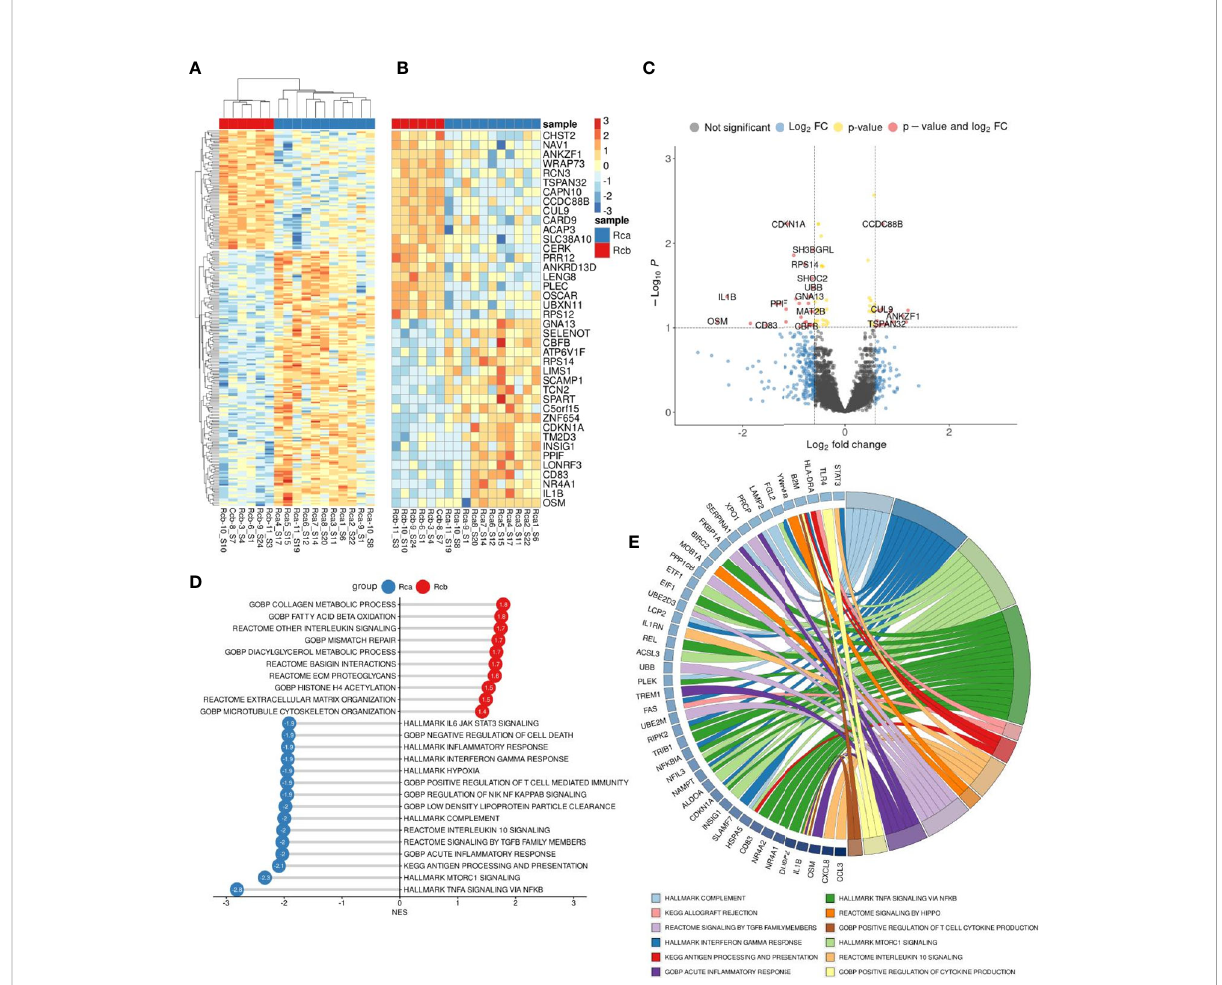
FIGURE 5 Comparative transcriptome of monocytes from rectal cancer patients before (Rca) and after (Rcb) neoadjuvant chemotherapy. (A) , Heatmap demonstrates hierarchical clustering of samples and upregulated and downregulated genes in RC patients after NAC (FDR<0.25). (B) , Heatmap with top 20 DEGs upregulated and downregulated in monocytes of in RC patients after NAC (FDR<0.1). (C) , Volcano plot shows p-value and log2 fold-change value for DEGs in monocytes of RC patients after NAC (|L2FC|>0.58, FDR<0.1). (D) , Bar plot with GSEA results demonstrates top deregulated pathways in monocytes of in RC patients after NAC (FDR<0.1). (E) , Chord plot demonstrates top upregulated pathways (FDR<0.01) and their top enriched genes (FDR<0.05) in RC patients after